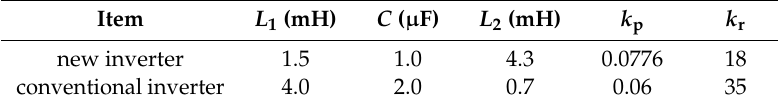
Figure 15. Photo of the experiment setup. Table 3. New and conventional experiment inverter parameters.